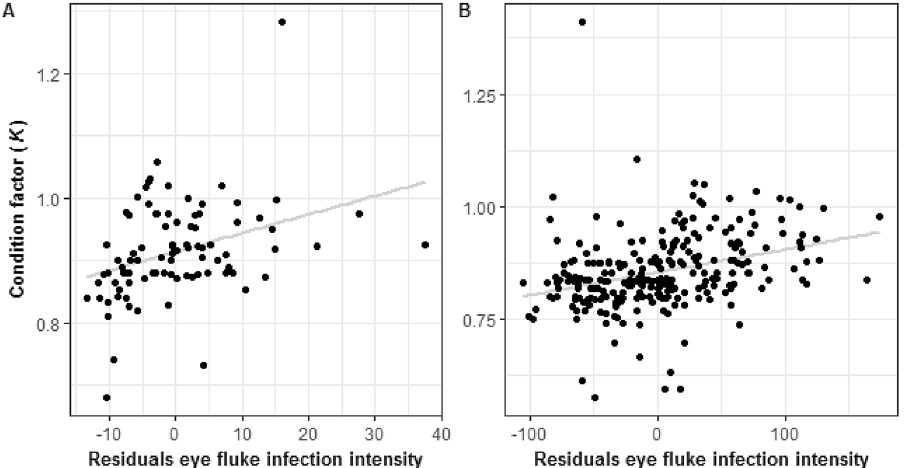
Figure 2. Relationship between eye fluke infection intensity corrected for fish size (residuals from the regression in Fig. 1) and condition factor ( K ) of YOY perch ( Perca fluviatilis ) from two locations of Lake Müggelsee ( A ) “South”, ( B ) “North” in 2014. The lines represents the best linear fit (South: y = 0.0029 x + 0.874; North: y = – 0.00059 x + 0.799).